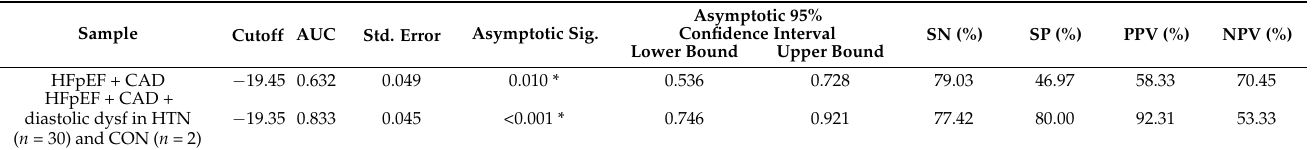
Table 5. Predictive performance of global longitudinal strain (%) for the diagnosis of HFpEF.